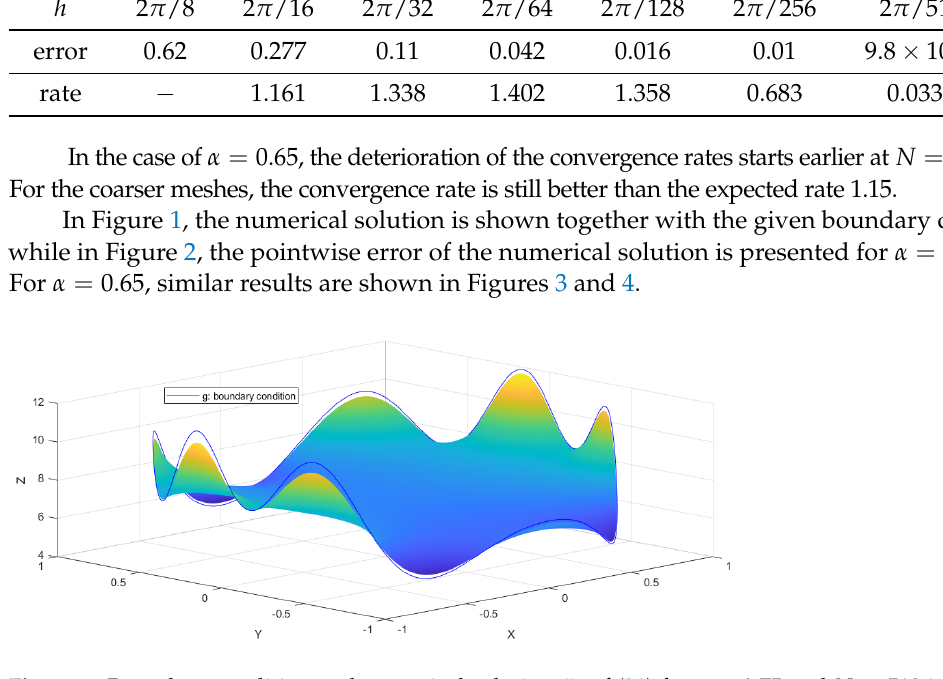
Figure 3. Boundary condition and numerical solution ˜ u h of (21) for α = 0.65 and N = 512 inside the domain. Figure 4. Pointwise error of the numerical solution ˜ u h of (21) for α = 0.65 and N = 512 inside the boundary. We can observe that the error is significantly larger than in the case of α = 0.75. 4. Discussion 214